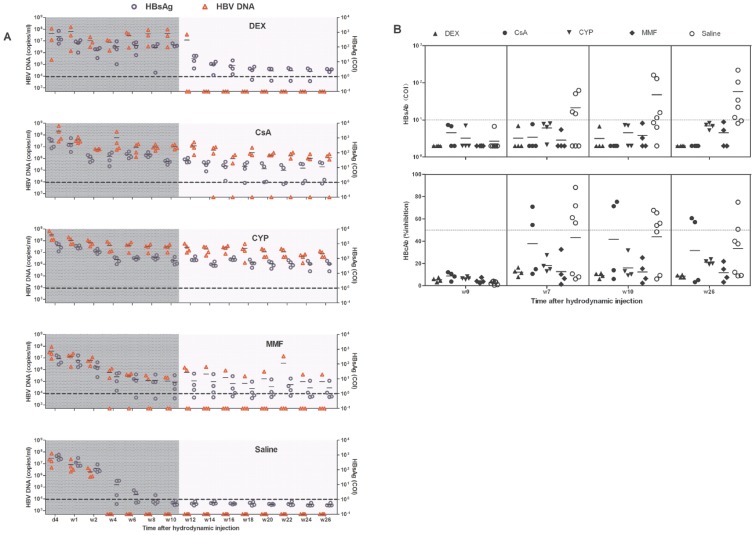
HBV persistence in mice receiving HI and immunosuppressive treatment.Mice were treated with saline or the immunosuppressive drugs DEX, CsA, CYP, or MMF from 1 week before the HI to 10 weeks after the HI, and they received the HI at w0. (A) The levels of serum HBsAg (circle) and HBV DNA (triangles) in the mice after the HI were detected using ECLIA, with the cut off values of 1.0 COI (dashed line) and 5×102 copies/ml, respectively. (B) The production of HBsAb and HBcAb in the mice was measured using ECLIA assay at w0, w7, w10, and w26 after HI. The cut off value of the HBsAb assay was 10 IU/L. The positivity of the HBcAb test was defined as inhibition >50%.